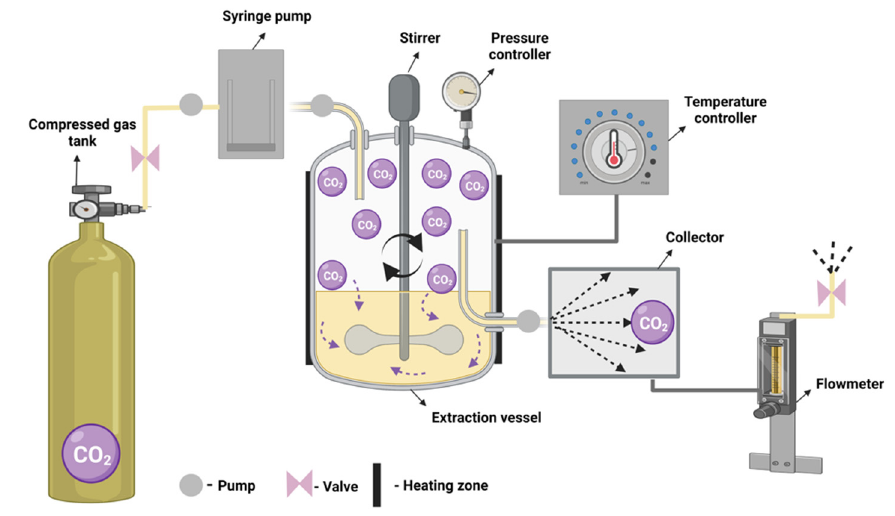
Figure 5. Supercritical fluid extraction.